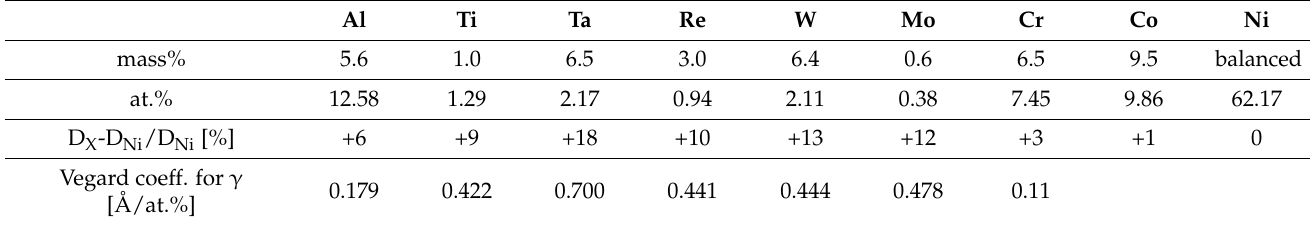
Table 1. Mass and atomic content of alloying elements for the CMSX-4 superalloy and percentage difference in atomic diameter from Ni, as well as the Vegard’s coefficients of alloying elements for the γ-phase. Al Ti Ta mass% 5.6 at.% D X -D Ni /D Ni [%] +6 +9 +18 Vegard coeff. for γ [Å/at.%] 0.179